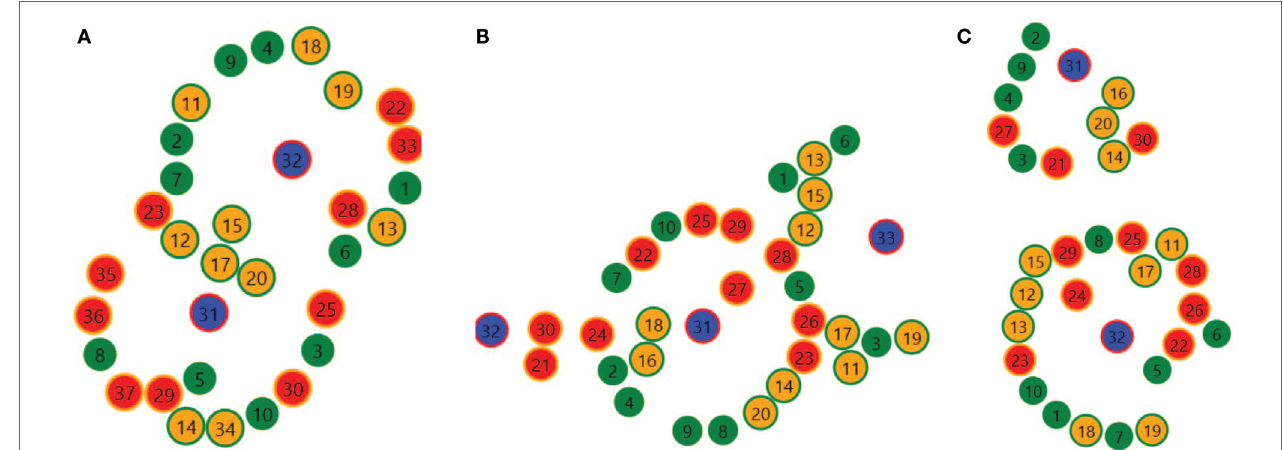
FigUre 12 | example of various agent arrangements in the 2D space: (a) One cluster composing of two adjacent groups, (B) stable central structure with impermanent neighboring groups, and (c) stable separated clusters